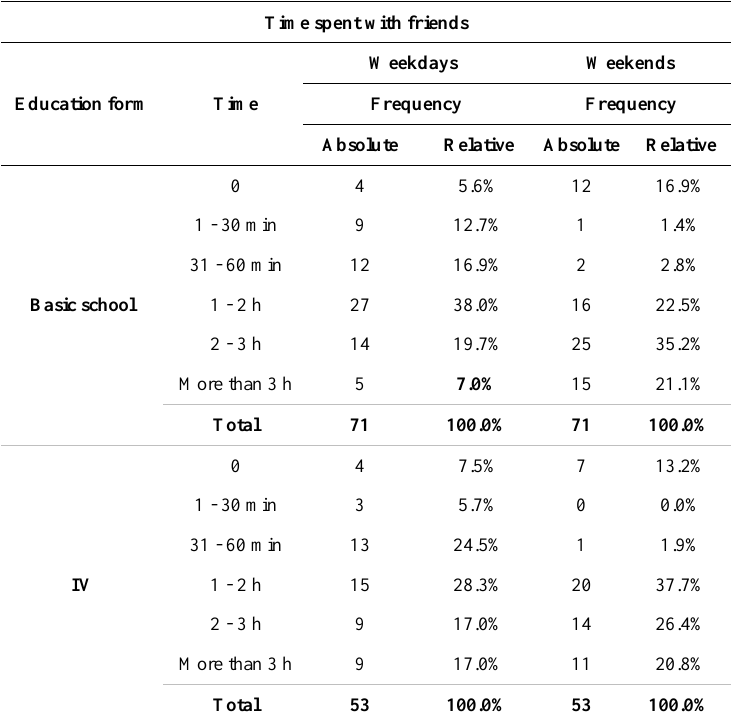
Table 3. Time spent with